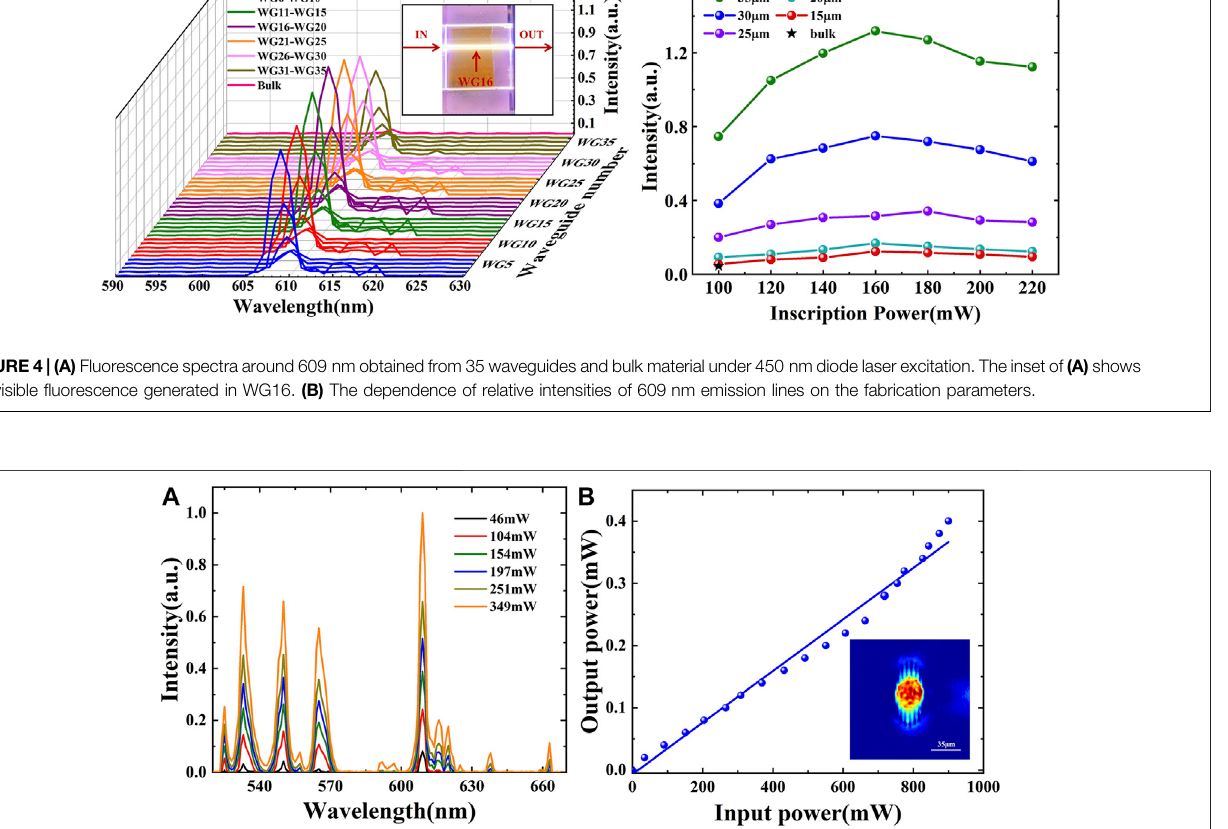
FIGURE 5 | (A) Overall spectra of the guided fl uorescence from WG16 measured with increasing excitation power. (B) Dependence between the output fl uorescencepowerandtheinputpowerfromWG16.Theblueballsrepresenttheexperimentalresultsandthesolidlineislinear fi ttingofexperimentdata.Theinsetof (B) is the mode distribution of waveguide fl uorescence obtained from